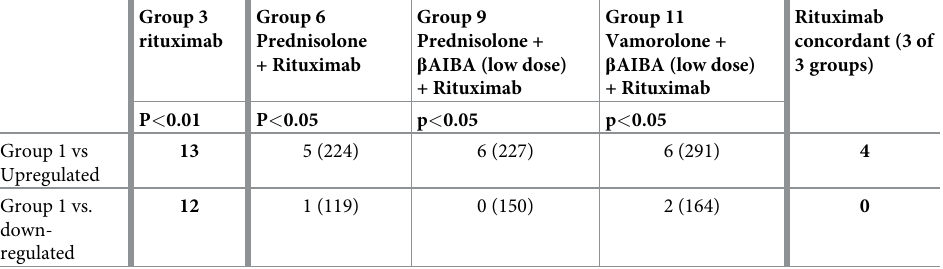
Table 5. Serum proteomics comparisons of drug-treated vs. non-treated controls (Group 1) for rituximab-treated mdx